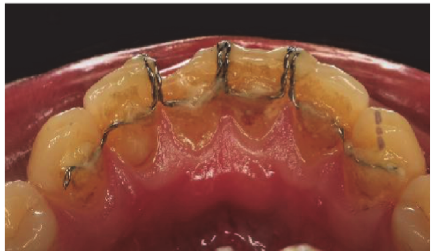
Figure 8: Intraoral lingual view of the bonded appliance showing plaque